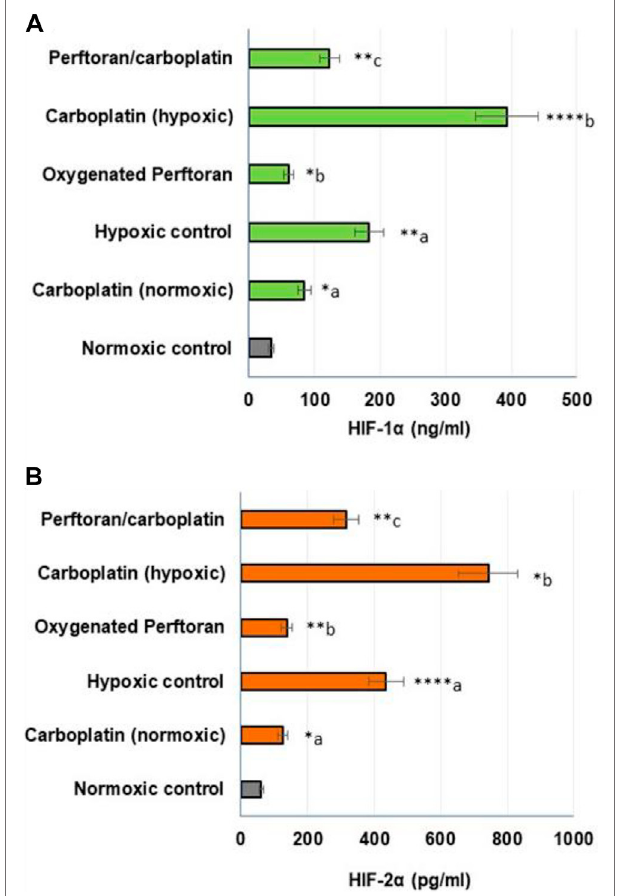
FIGURE 2 | Evaluation of HIF-1 α (A) and HIF-2 α (B) proteins in lung A549 cells: The protein concentrations were determined by ELISA (HIF-1 α (ng/ml); HIF-2 α (pg/ml); n = 8; mean ± SE). a compared with normoxic control; b compared with hypoxic control; and c compared with carboplatin- treated hypoxic cells, * p < 0.05, ** p < 0.01, *** p < 0.001, and **** p < 0.0001.